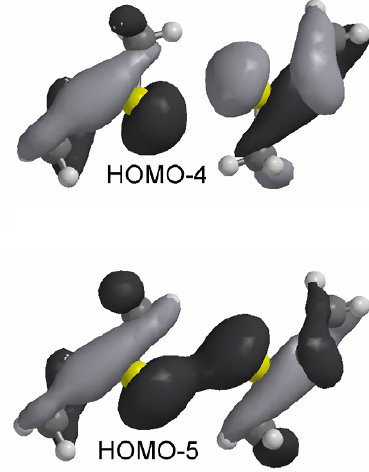
Figure 8. Sulfur-sulfur-related molecular orbitals for the dimer shown in Fig. 6. Fig. 8 shows molecular orbitals for the dimer shown in Fig. 6, illustrating the interaction between the two sulfur centers. HOMO-5 has a bonding character and may be taken as evidence of bonding between the two sulfurs; however, since its corresponding antibonding orbital, HOMO-4, is also filled with electrons, the net result should be no bonding between the two sulfurs – at least not involving these orbitals.